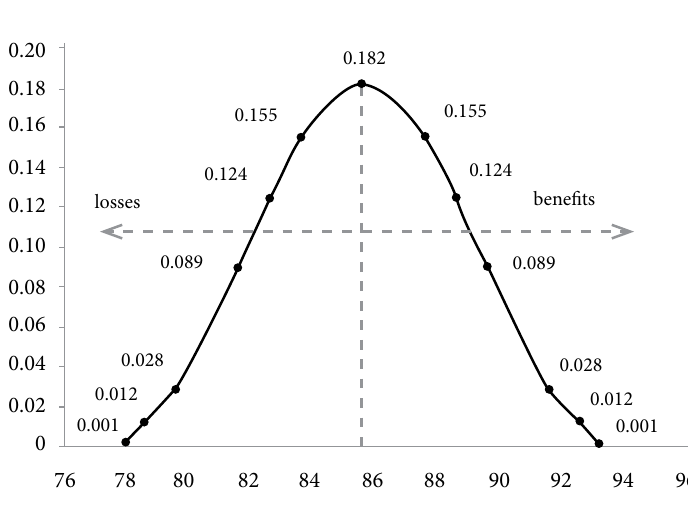
Fig. 3. Summarized curve of